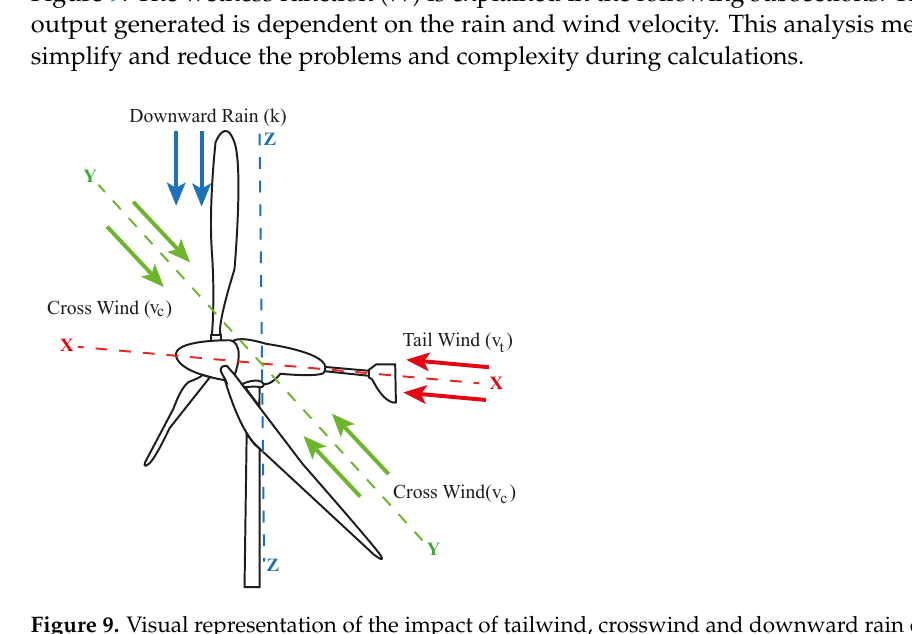
Figure 9. Visual representation of the impact of tailwind, crosswind and downward rain on F d . Wetness Modeling of the WT